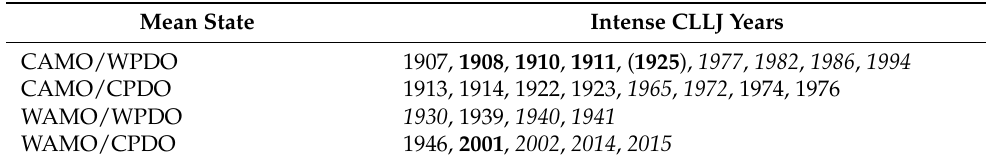
Table 2. Intense years of the Caribbean low-level jet (CLLJ) during indicated mean states. According to the criteria of the Oceanic Niño Index (ONI) years in bold are La Niña events, italic years are El Niño events, and the remaining years are neutral conditions.